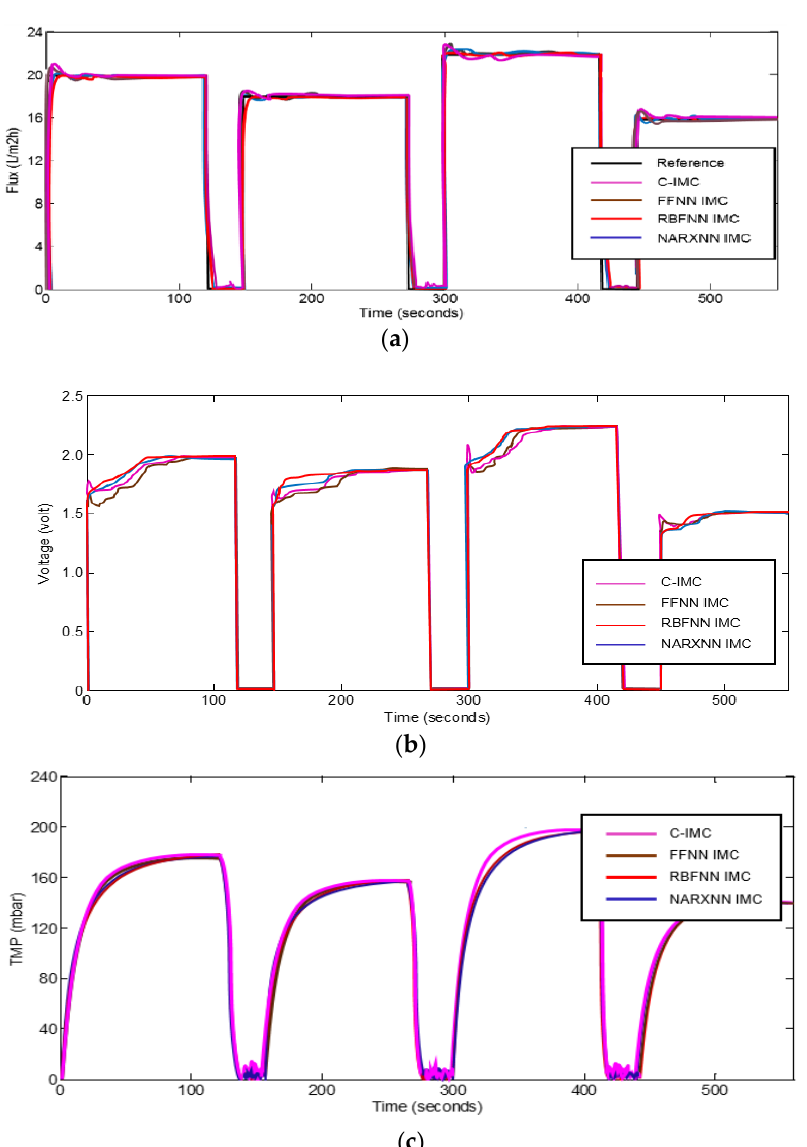
Figure 17. ( a ) Flux of setpoint change; ( b ) voltage of setpoint change; ( c ) TMP effect of the set point change.